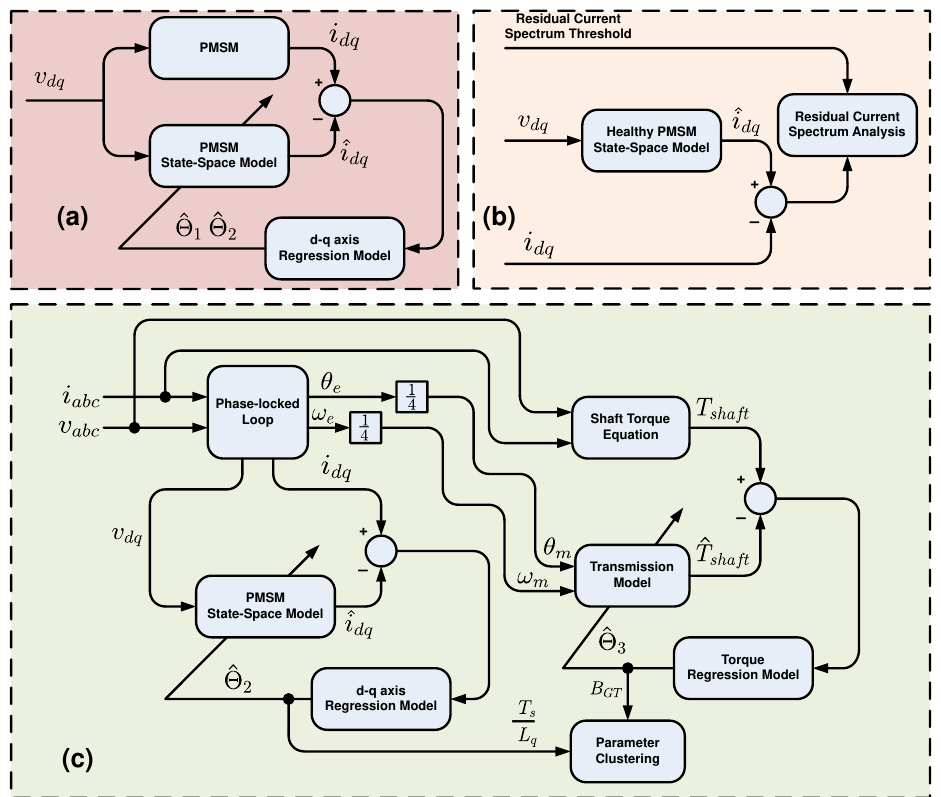
Figure 1. PMSM model-based fault detection and identification: ( a ) healthy PMSM model identifica- tion; ( b ) residual current spectrum analysis; ( c ) parameter